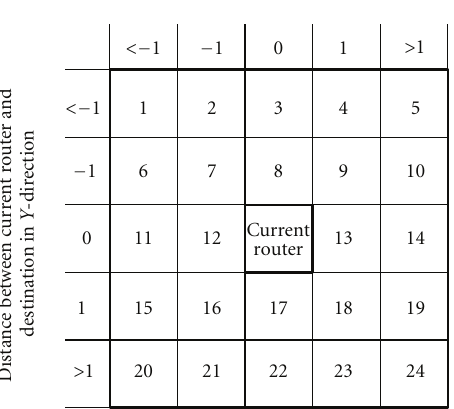
Figure 4: Routing directions in our experimental routing algo-